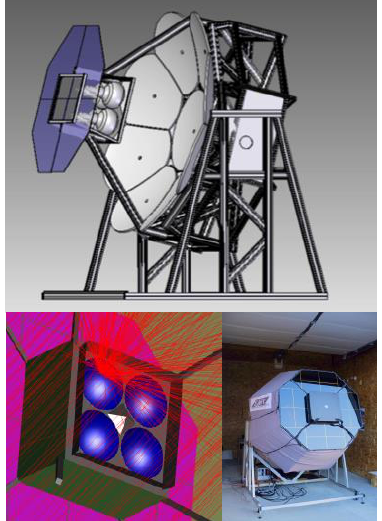
Fig. 1. Picture of the FAST telescope, FAST CAD model of the whole telescope and details of the camera composition from ray tracing software.